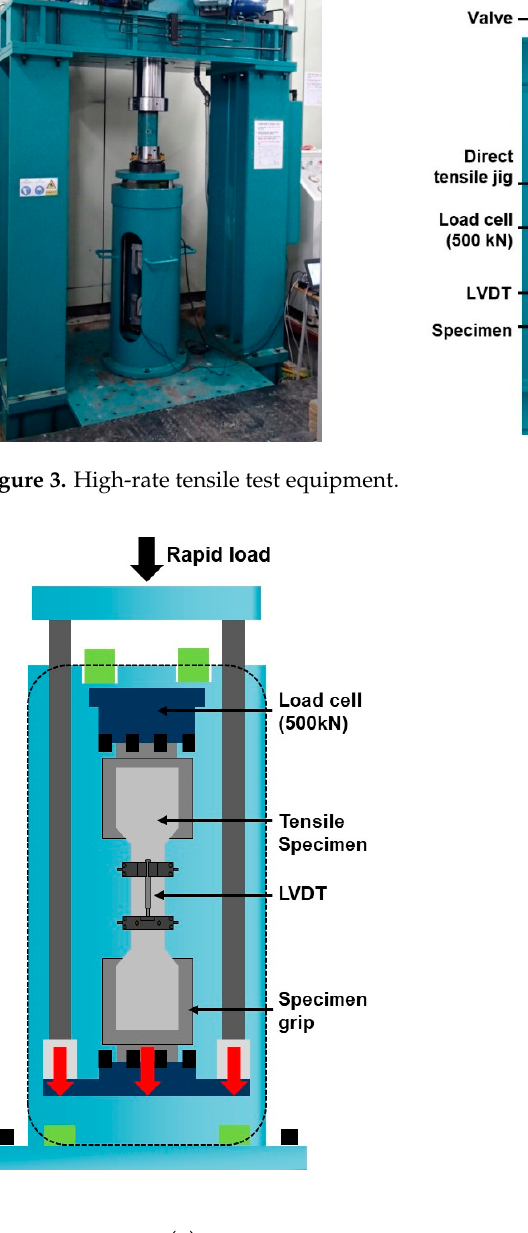
Figure 4. Schematic diagram of the direct tensile jig: ( a ) before the tensile test; ( b ) after the tensile test.